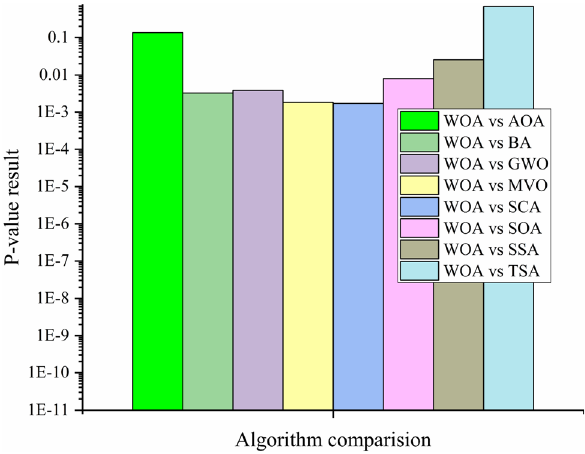
Fig. 18 The p-value test of the algorithms for case